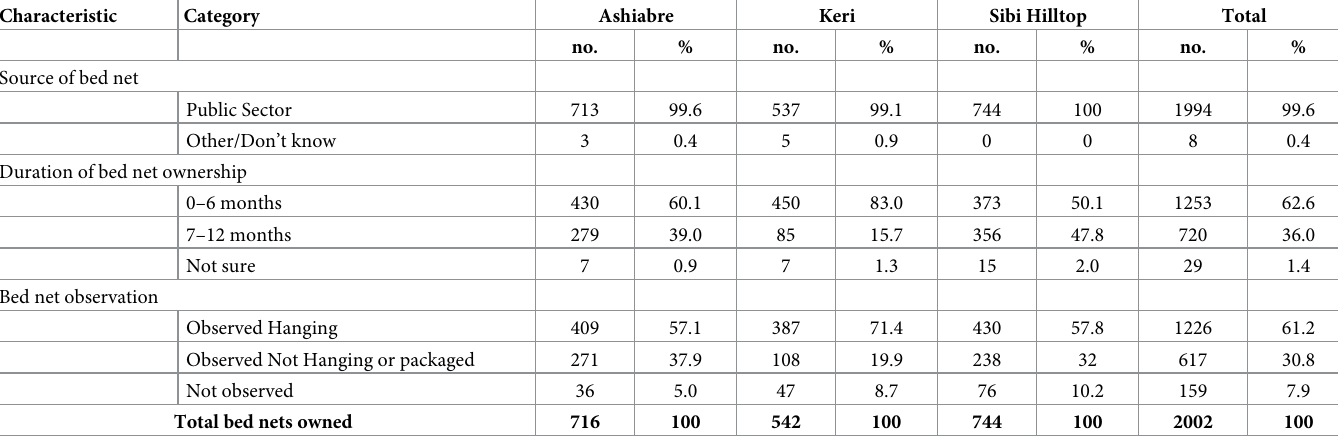
Table 5. Source, duration of ownership, and observation of bed nets owned by